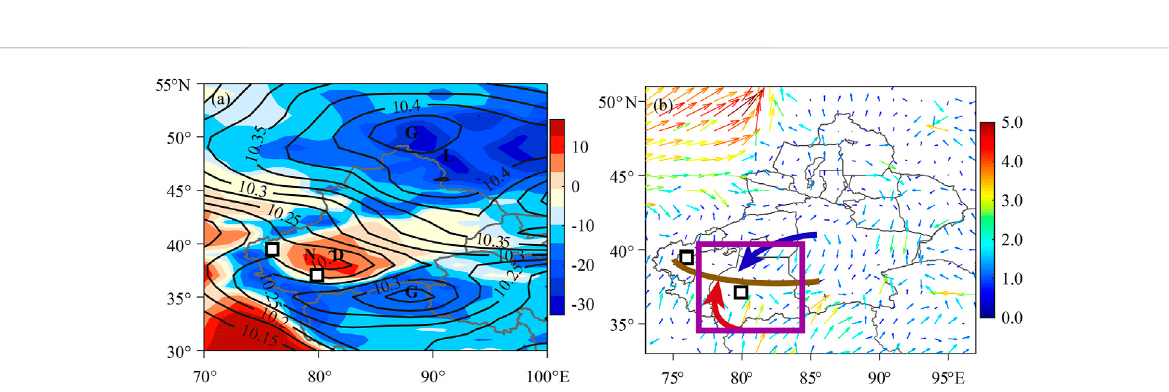
The seasonal variation of monthly average PM 2.5 concentration in each region of Xinjiang is shown in Figure 5. Speci fi cally, the variation characteristics in region I and region III are similar, exhibiting high concentration in winter (October to March of the next year) and low concentration in summer (April to September). The pollution in region Ⅲ is prominent in autumn and winter, with the average concentration increasing from 28.04 μ g · m − 3 in summer to 101.96 μ g · m − 3 in winter. In region Ⅳ , the peak of PM 2.5 concentration appears in March, which may be caused by the dust weather process in spring. Affected by factors of alternative freezing and thawing of soil, scarce precipitation and frequent cold air activities, the number of days of dust